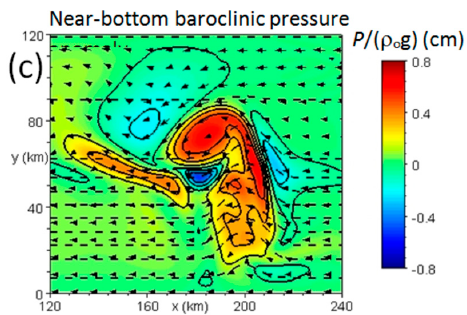
Figure 14. Canyon-upwelling scenario: ( a ) the surface pressure field in conjunction with surface currents; ( b ) the surface pressure anomalies (the upstream pressure field has been subtracted), again with surface currents; and ( c ) the baroclinic pressure component in conjunction with horizontal currents near the seafloor. Components of dynamic pressure (solid lines and color shading) and horizontal velocity fields (arrows) after 10 days of simulation. Every 8th vector is shown.